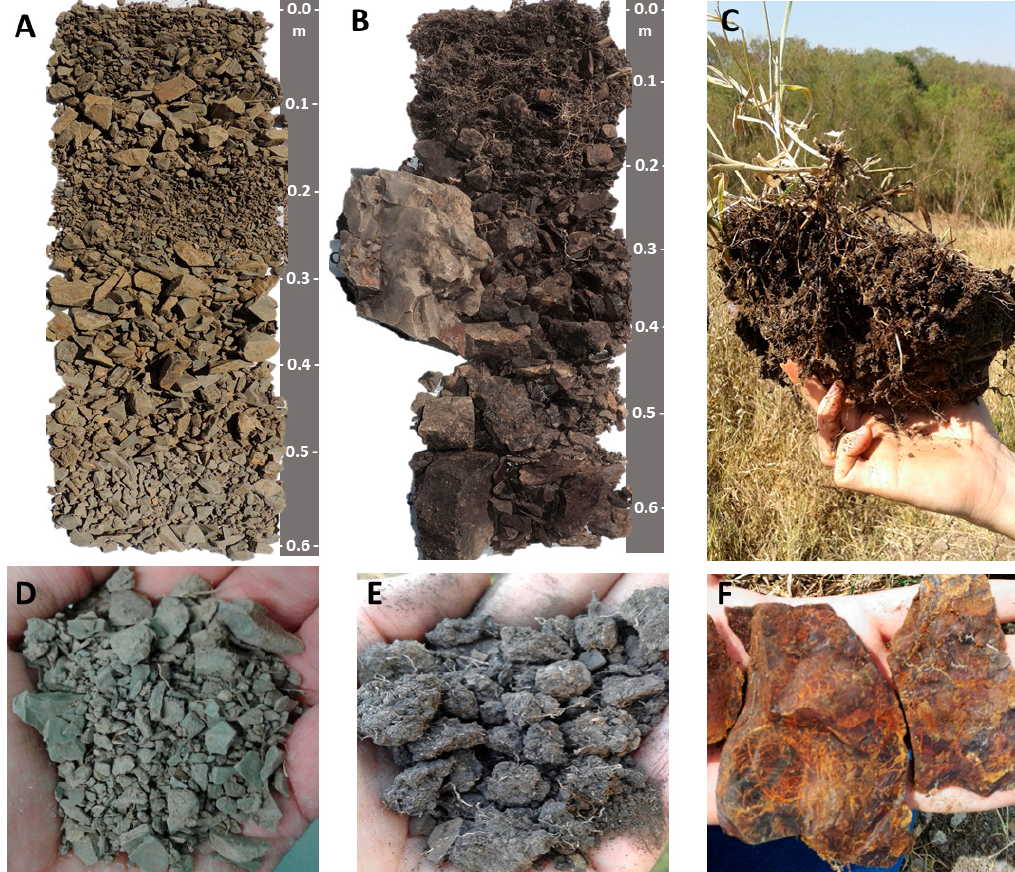
Figure 2. ( A ) Two year-old Technosol soil profile; ( B ) 20 year-old Technosol soil profile; ( C ) Soil structure produced by the high root density and activity; ( D ) Weakly developed soil structure in the two-year-old Technosol; ( E ) Well-developed structure from the surface horizon of the 20-year-old Technosol; ( F ) Altered artefacts (black shale): Oxidation and fragmentation induced by root growth between the shale laminations.